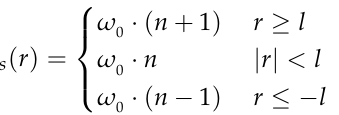
－ l Figure 3. The actuator dead zone in speed regulation.